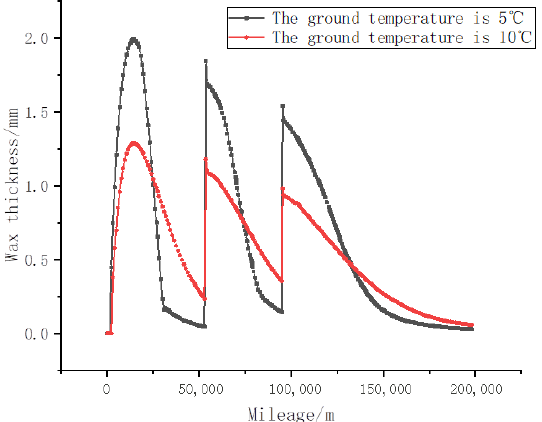
Figure 7. Wax deposition thickness at different ground temperatures.